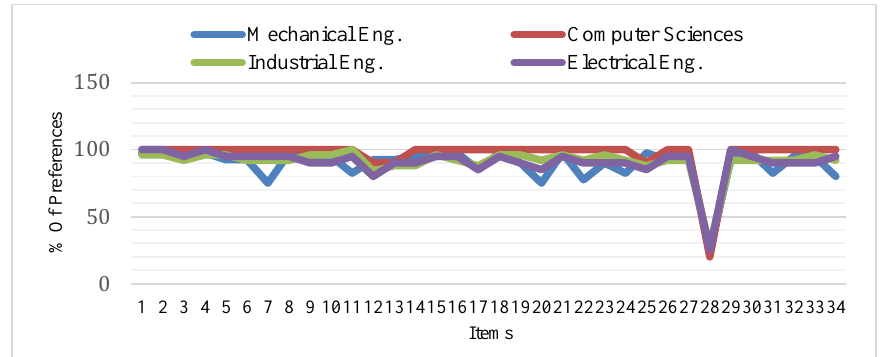
Fig. 4. Preferences of the different items related to the evaluation of the training course in EP by engineering